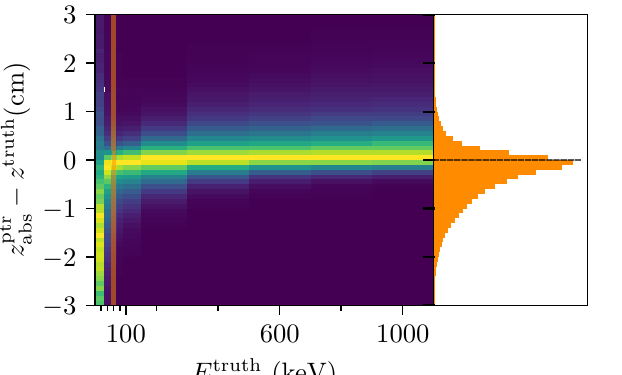
determina- normalized in each column to the maximum value. Vertical orange bars abs show the energy and polar angle of the standardized working point and indicate the position of the profile histograms shown on the